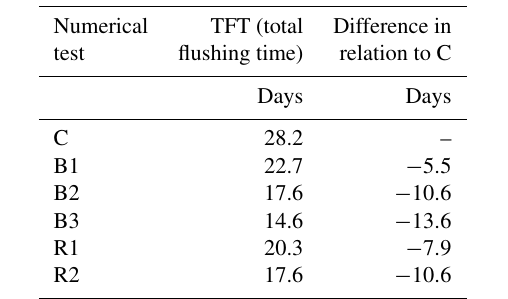
Table 3. TFT values for the surface e -flushing time in the Alfacs Bay.